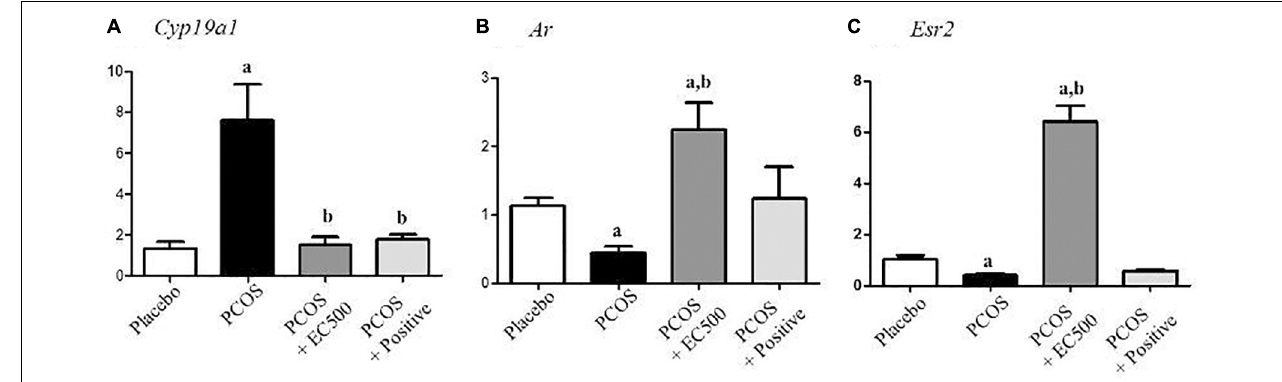
FIGURE 6 | Effect of E. cava treatment on hormone receptor genes. For PCOS experiments, 6-week-old female rats were administered letrozole pellets (0.1 mg/kg/day). After 2 weeks, E. cava extract was administered via P.O. treatment every day for 2 weeks. (A) Cyp19a1 , (B) Ar , and (C) Esr2 mRNA levels were determined by quantitative RT-PCR. Gapdh mRNA was used as an internal control. Values represent the means ± SEM. a p < 0.05 vs. placebo group, b p < 0.05 vs. PCOS group. EC, E. cava extract; PCOS, polycystic ovary syndrome.